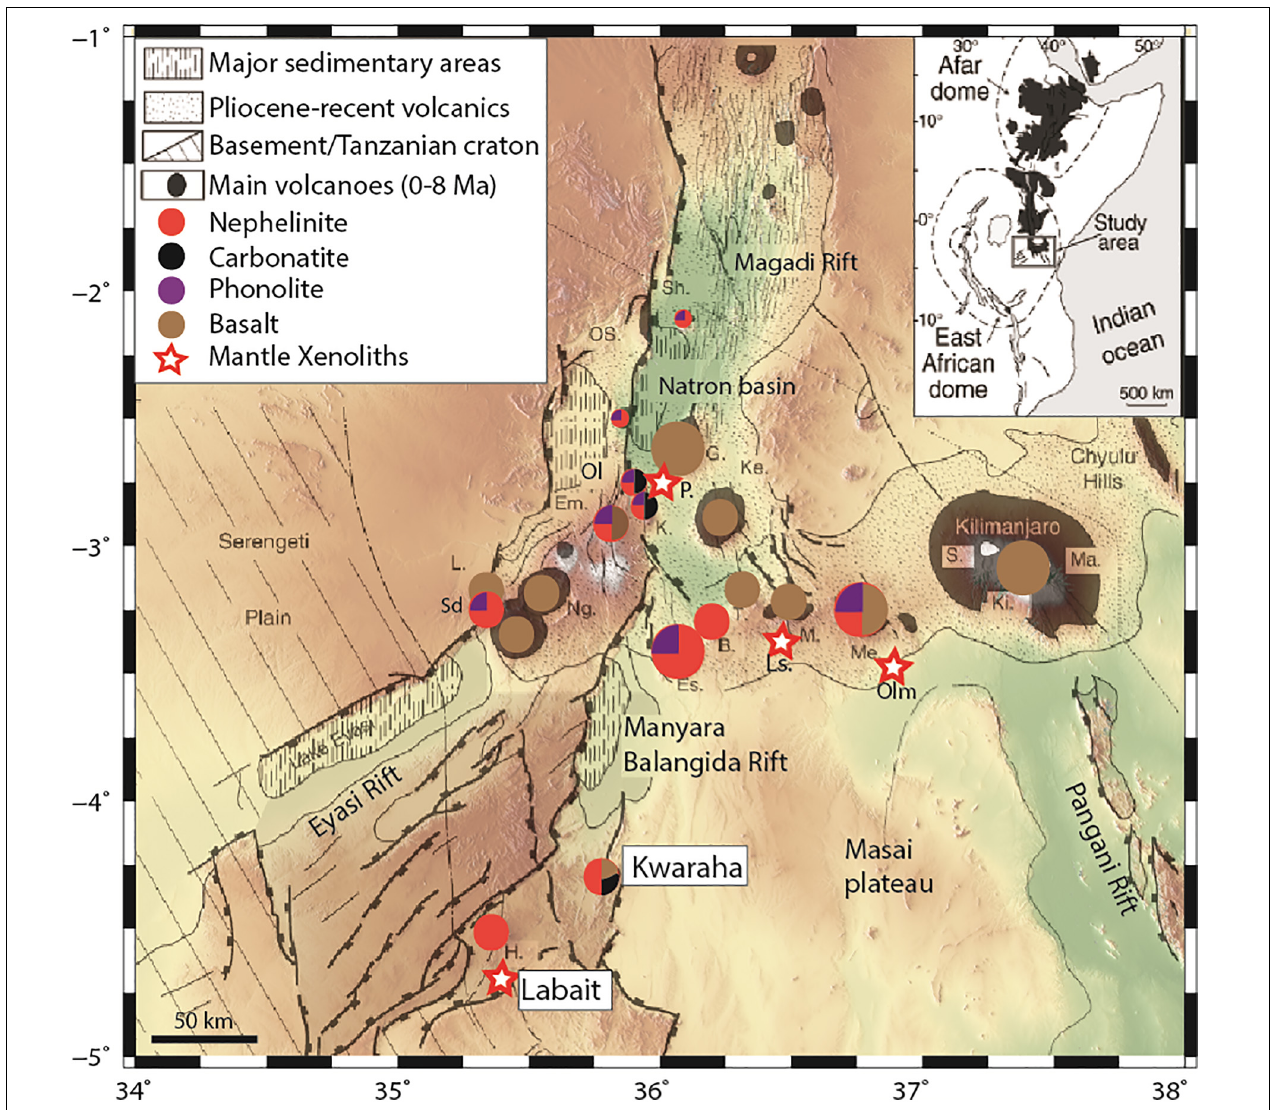
FIGURE 1 | Main structural and magmatic features of the North Tanzanian Divergence, and the locations of Labait and Kwaraha. Proportions of symbol colors represent relative eruptive volumes of magma composition for single volcano (nephelinite, phonolite, carbonatite, basalt). Volcano names are abbreviated as: